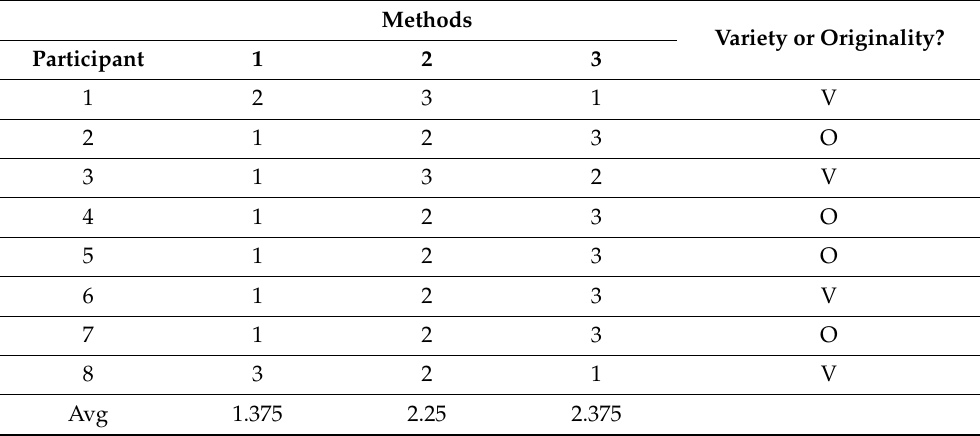
Table 5. Perception of the participants on the preference of using models to generate persuasive visual messages (the higher the value, the higher the